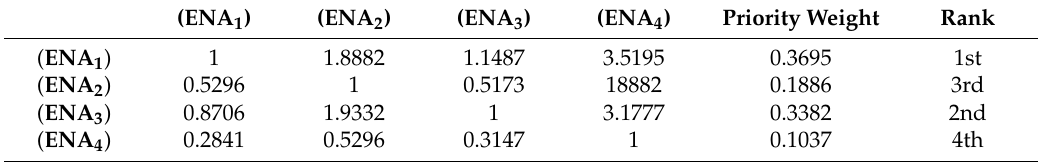
Table A5. Pair-wise comparison matrix of environmental sub-factor.